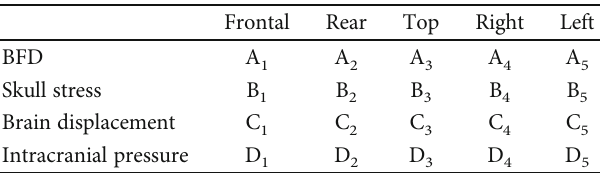
Table 2: Corresponding serial number of measurement impact